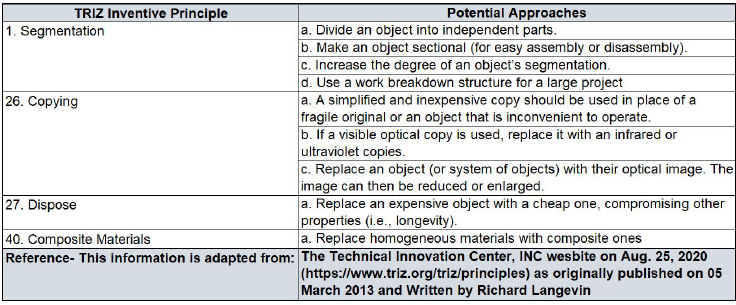
Figure 13. TRIZ Inventive Principles with Details to Address Technical Requirements Conflict 1.